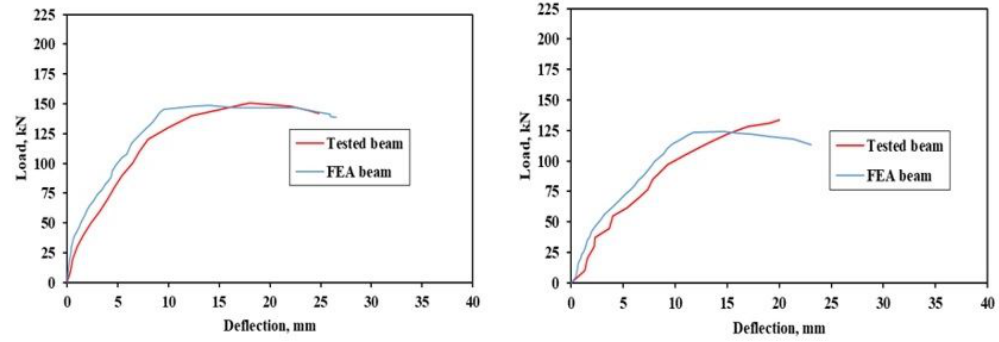
Figure 19: The experimental and numerical results of load-midspan deflection curves of the specimens PB6 (left) and PB7